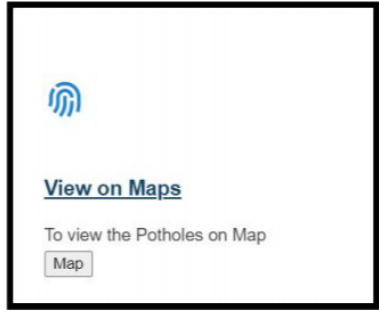
Figure 10. View on maps feature on the